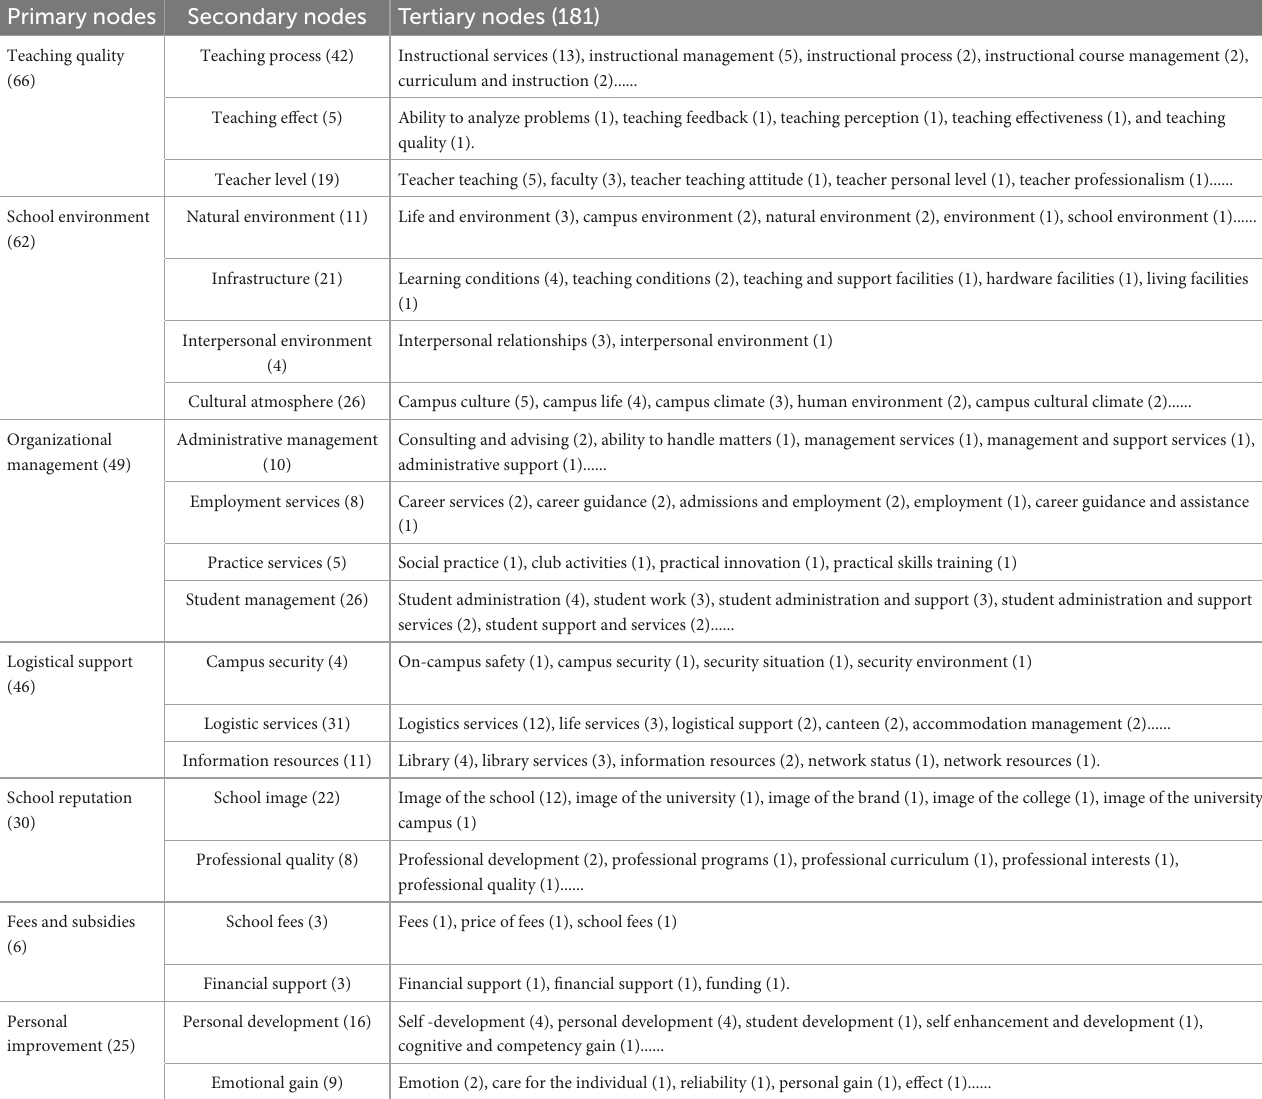
TABLE 1 Coding statistics of factors influencing satisfaction of Chinese university students. Primary